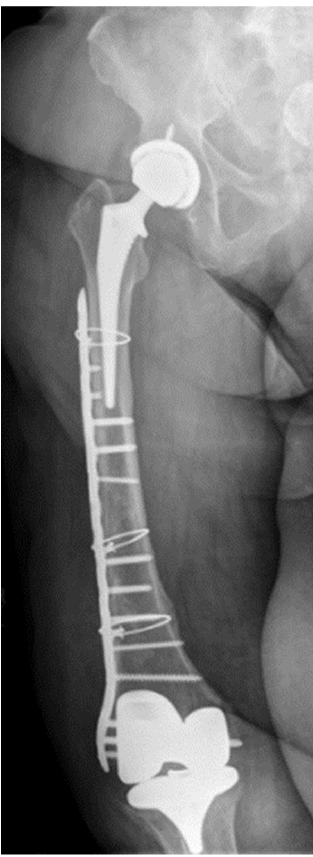
Figure 1. Knee and hip prosthetics with lateral plate with three cerclage wires. Given the sinus tract and the extent of hardware infection (knee prosthetic, lateral plate and hip prosthetic) in correlation with erosion of the medial condyle, salvage of her prosthesis was not feasible as the prosthetic was loose. Therefore, explantation of all hardware followed by reconstruction with a right revision hip replacement and knee replace- ment with total femur implant was deemed the best chance to eradicate the infection, sal- vage her lower extremity and allow for ambulation. However, given the extent and